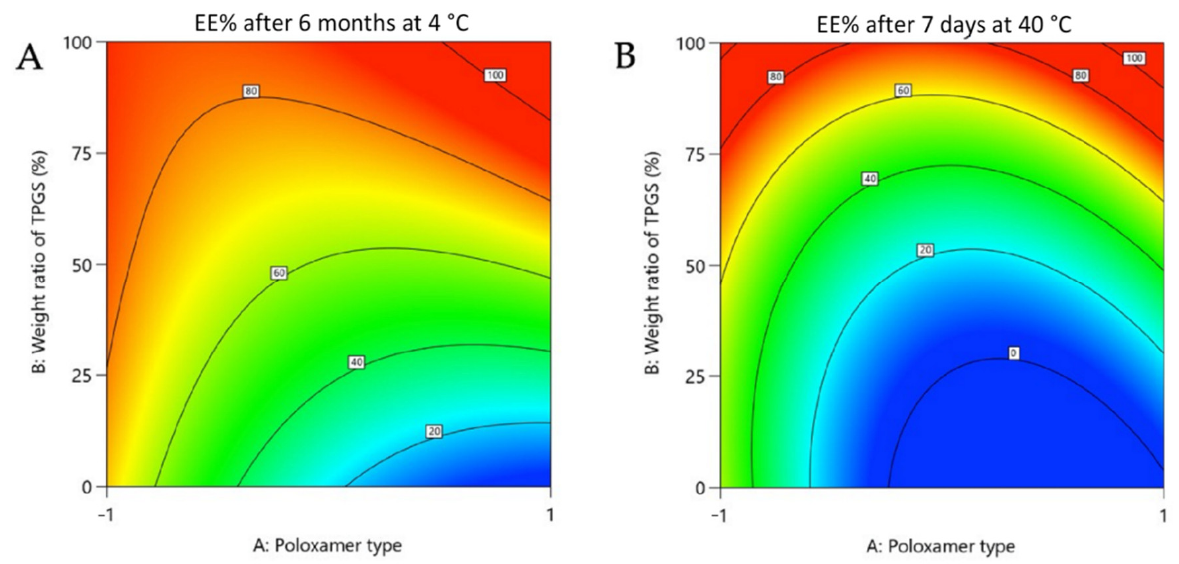
Figure 4. Contour plot showing relative effect of poloxamer type and weight ratio of TPGS on ra- pamycin EE% after 6 months at 4 °C ( A ) and 7 days at 40 °C ( B ).